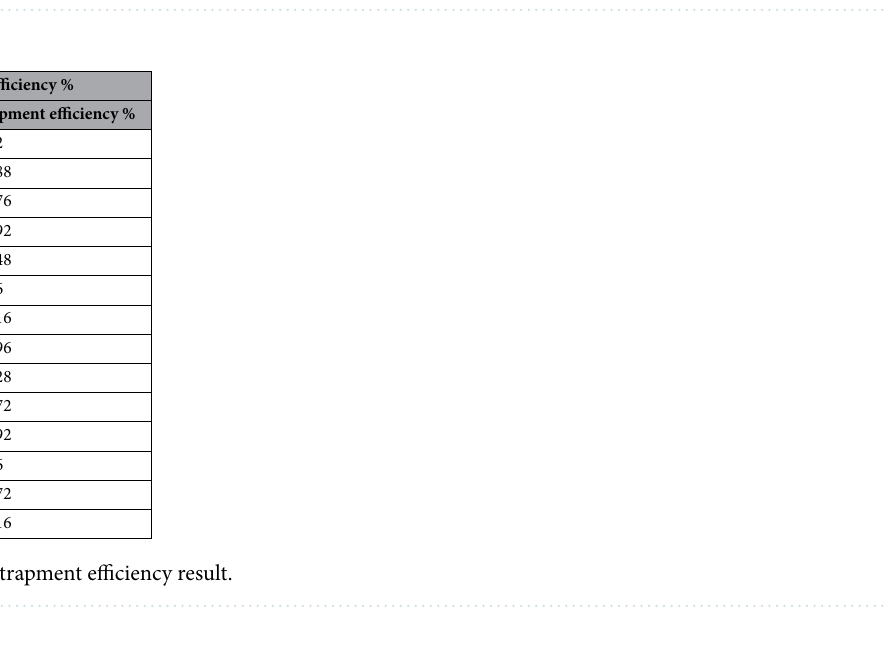
Table 2. Formulations using PBS with drug hydration medium.